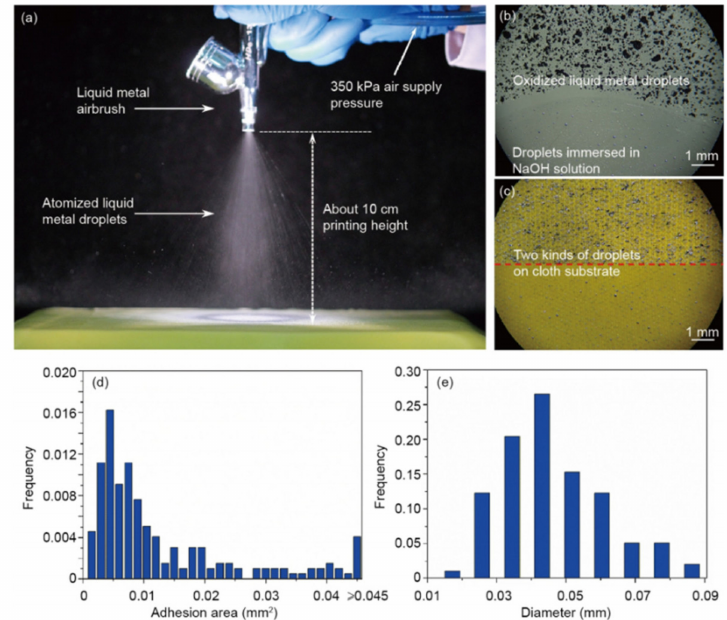
Figure 6. ( a ) Droplets generated by the airbrush. Light microscope image of spraying oxidized LM droplets and reduced droplets by immersing in NaOH solution on transparent glass substrate ( b ) and on cloth substrate ( c ). Statistical graph of the size distribution of oxidized droplets after impacting the substrate ( d ) and the droplets after removing their oxidized layer and shrinking into spheres ( e ). Reprinted with permission from Ref. [4]. Copyright 2016 Springer